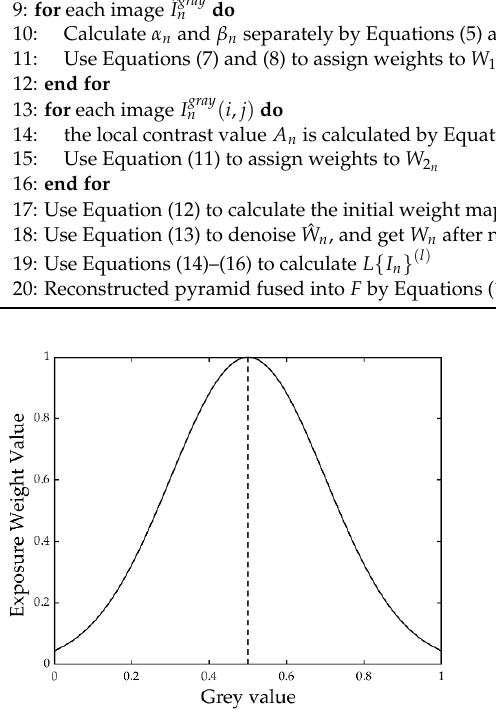
Figure 1. Schematic of the proposed method. The operation process of " ∗ " in the figure is shown in Equation (17). Algorithm 1: The proposed algorithm.